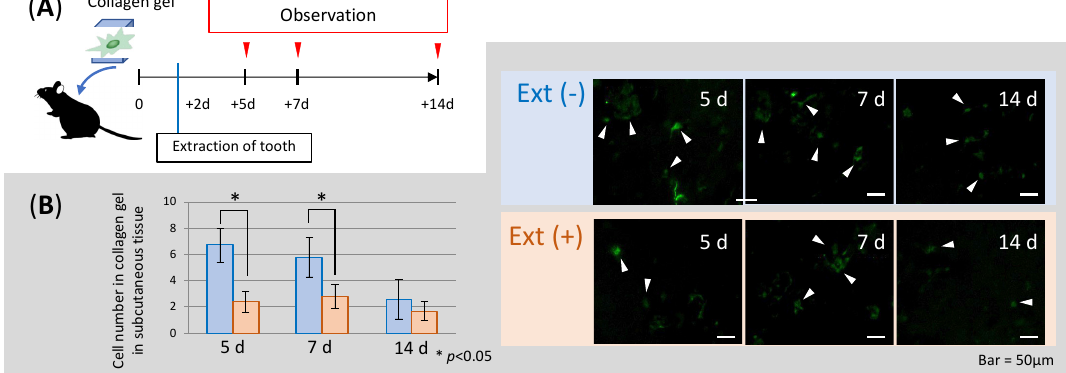
Figure 3. Changes in cell number in the sca ff old after tooth extraction. ( A ) Wild-type C57BL / 6N mice received tooth extraction 2 days after collagen injection with MSCs. After further 3, 5, or 12 days, the numbers of cells in the collagen gel were compared between extraction and no-extraction groups. ( B ) In the extraction group (5 and 7 days), a remarkable reduction of cells in the sca ff old was observed (Number of cells per 500 × 500 µ m field in section). * p <